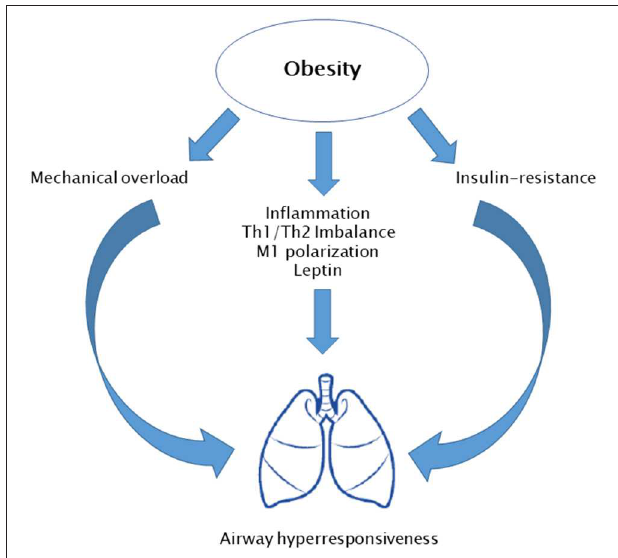
FIGURE 4 | Potential mechanisms involved in obesity-related asthma.